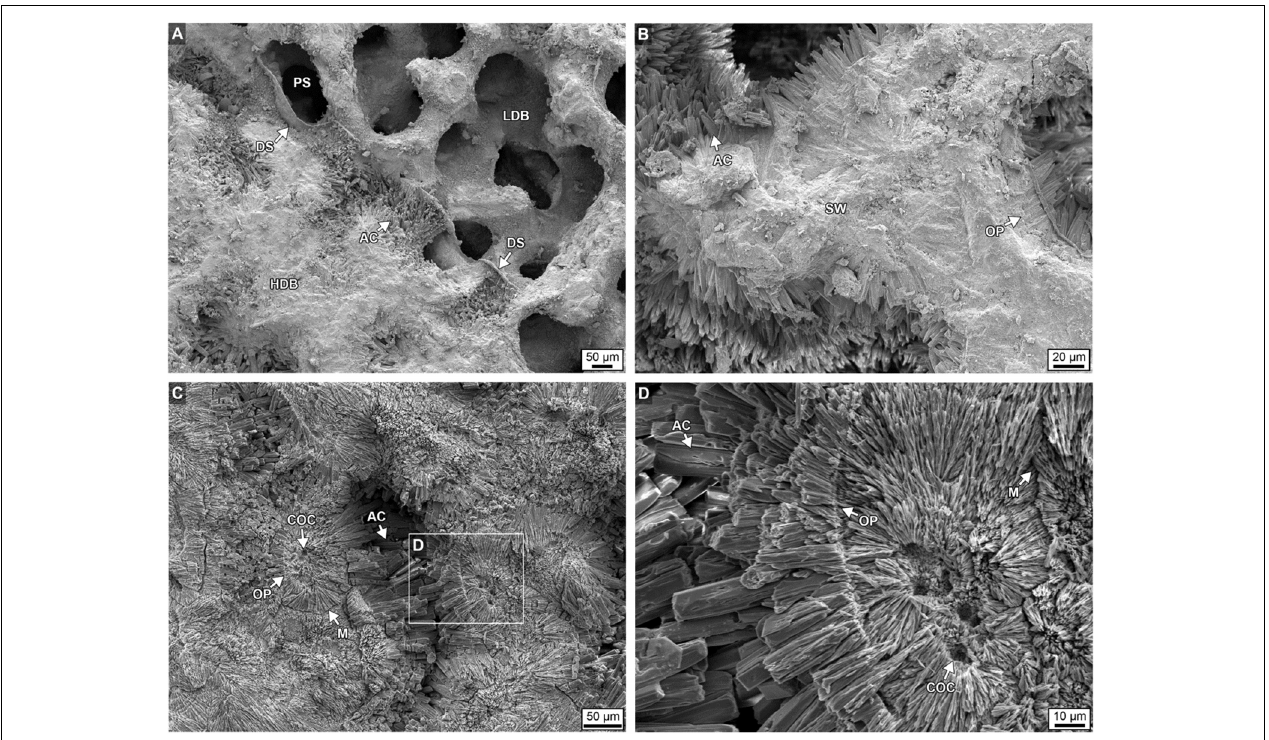
FIGURE 13 | Scanning electron microscope (SEM) images showing extensive diagenetic aragonite cements (AC) occluding pore space within a high-density band (HDB) from the bottom 6 cm of Core 3. (A,B) Unetched skeleton. (C,D) Skeleton etched in dilute 1% formic acid for 30 s. Labeling includes: PS, pore space; SW, skeletal wall; COC, center of calcification; DS, dissepiments; AC, acicular aragonite cement with both sharp and blunt crystal terminations; OP, original pore margins; and M, contact margins between individual